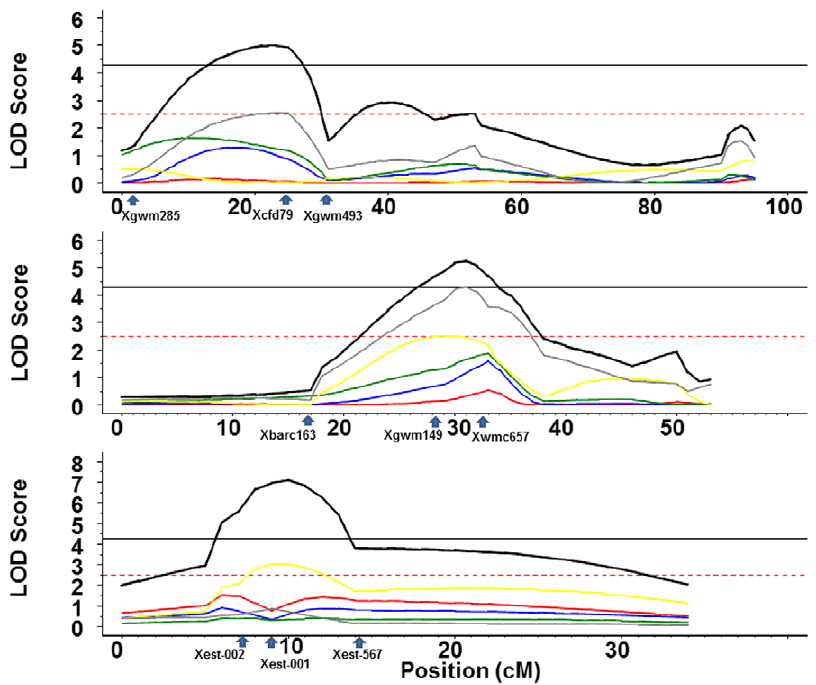
Figure 3. Multi-environment analysis and locations of QTL for resistance to Karnal bunt. ( A ) chromosome 3BS with markers Xgwm285 (at 0 cM), Xcfd49 (at 25 cM where the QTL is located), Xgwm493 (at 31 cM), and Xgwm108 (at 47 cM); ( B ) chromosome 4BL with marker Xgwm495 (at 0 cM), Xbarc163 (at 17 cM), Xgwm149 (at 29 cM where the QTL is located), Xwmc657 (at 33 cM), and Xgwm513 (at 38 cM) and ( C ) chromosome 5DL with markers X6augwm20 (at 0 cM), Xest-ksm2 (at 5 cM), Xest-002 (at 7 cM), Xest-001 (at 9 cM where the QTL is located), and Xest-567 (at 14 cM). LOD score is plotted against marker location. QTLs profiles legend with color red, blue, green, yellow, gray and black are KB01, KB02, KB03M, KB04M, KB05M, and joint effect respectively. Horizontal lines with black solid color mean threshold for Joint profile, and red dashed is threshold for marginal profiles.